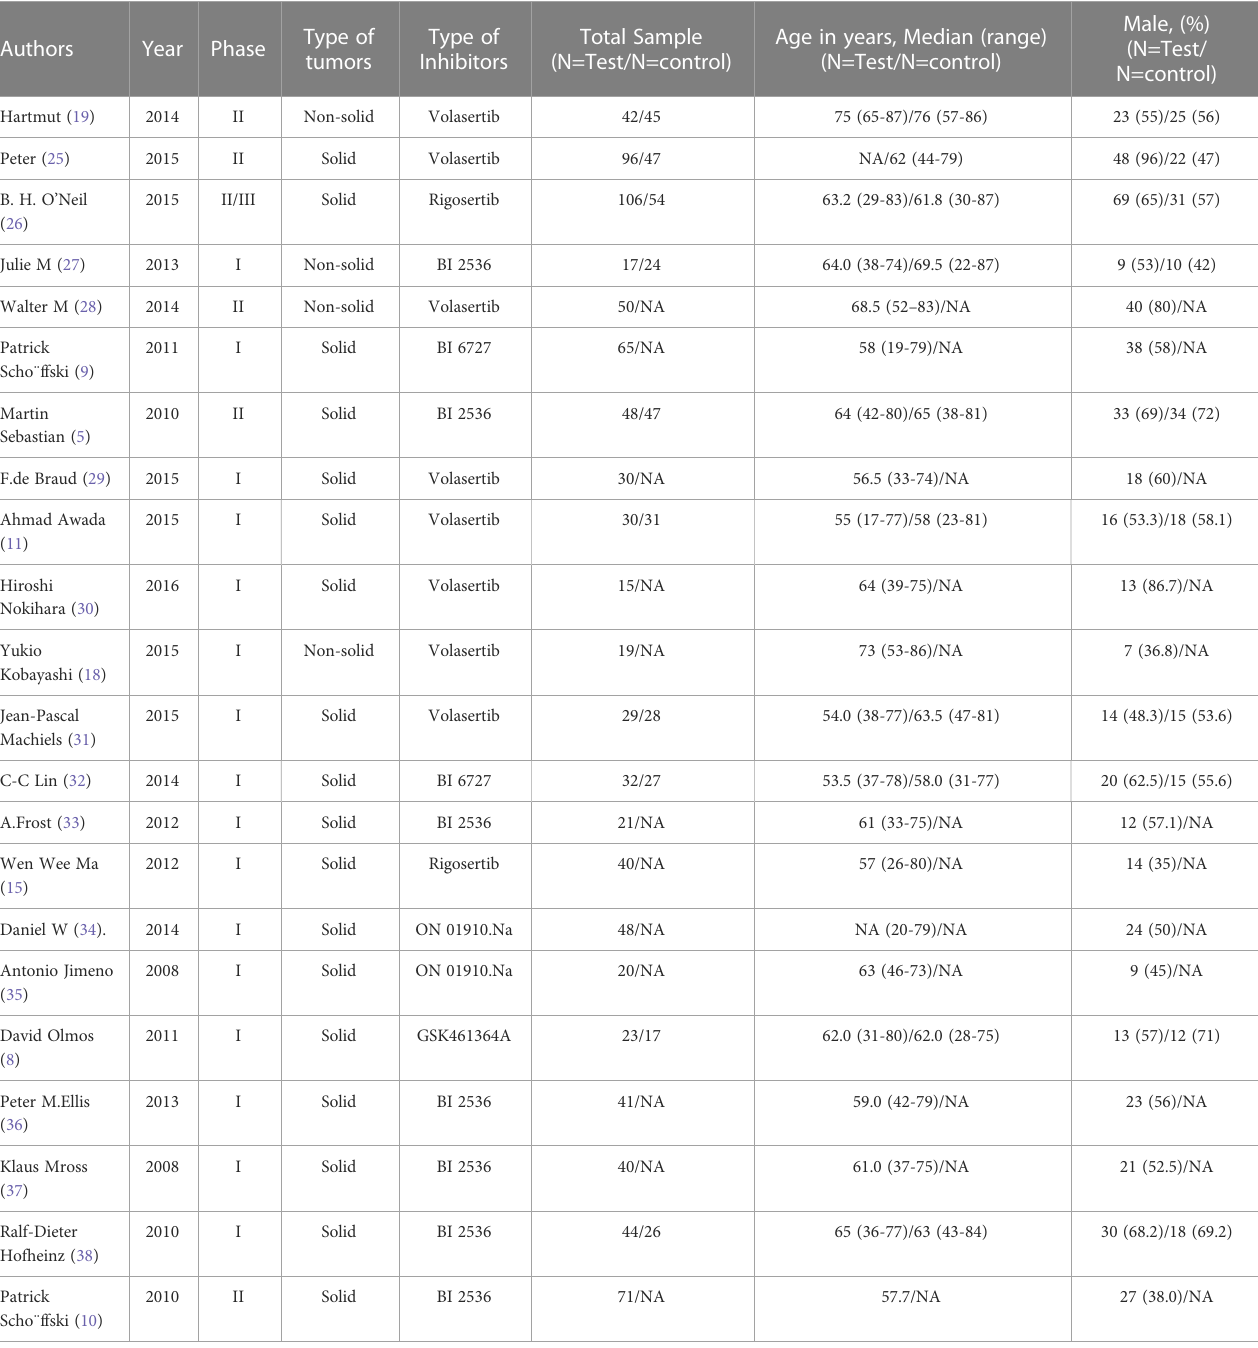
TABLE 1 Characteristics of the clinical trials included in the